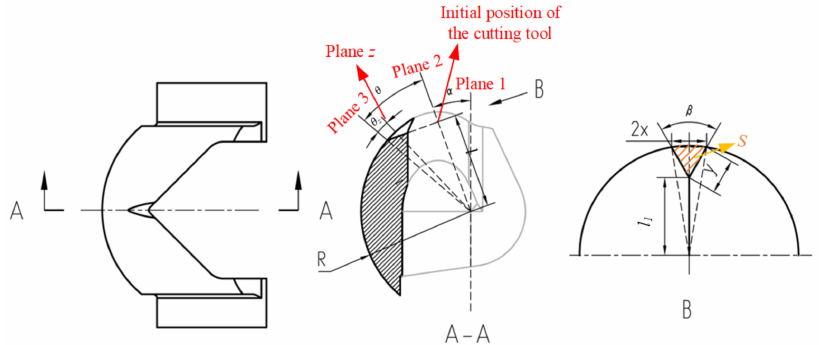
Figure 6. Improvement #1 of the